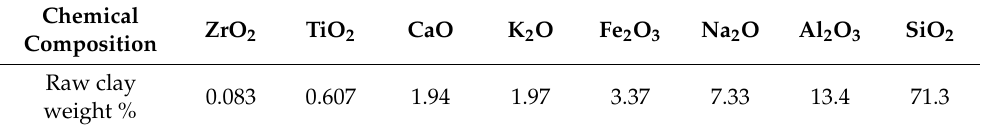
Table 7. Chemical analysis of natural mineral clay